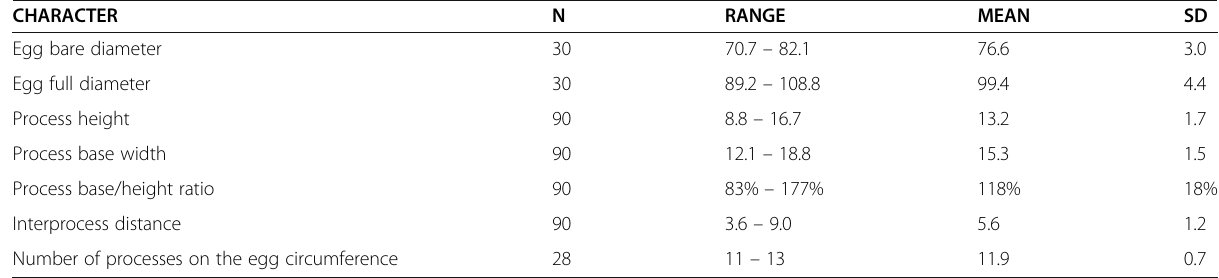
Table 11 Measurements [in μ m] of selected morphological structures of the eggs of Macrobiotus ripperi sp. nov. from Poland (PL.015) mounted in Hoyer ’ s medium (N – number of eggs/structures measured, RANGE refers to the smallest and the largest structure among all measured specimens; SD – standard